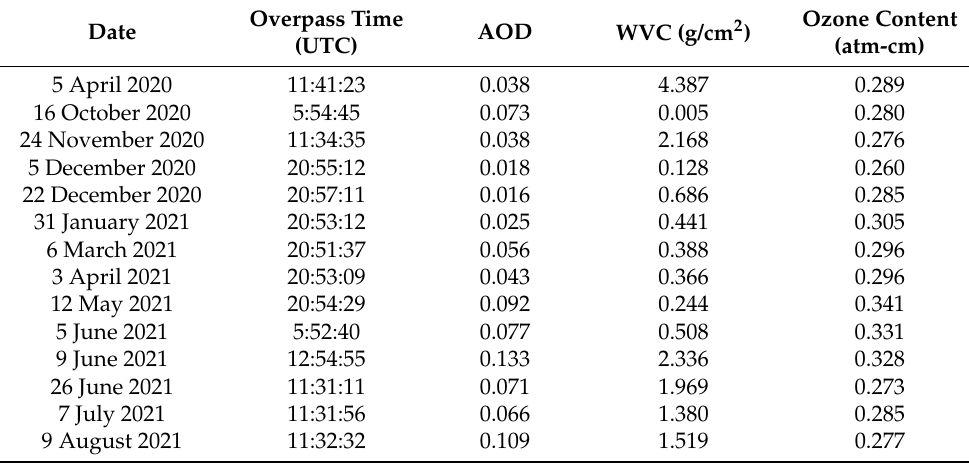
Figure 6. The BOA reflectance provided by RadCalNet used to calibrate OHS-F CMOS2. Table 3. The atmosphere parameters when the satellites pass over the RadCalNet sites.